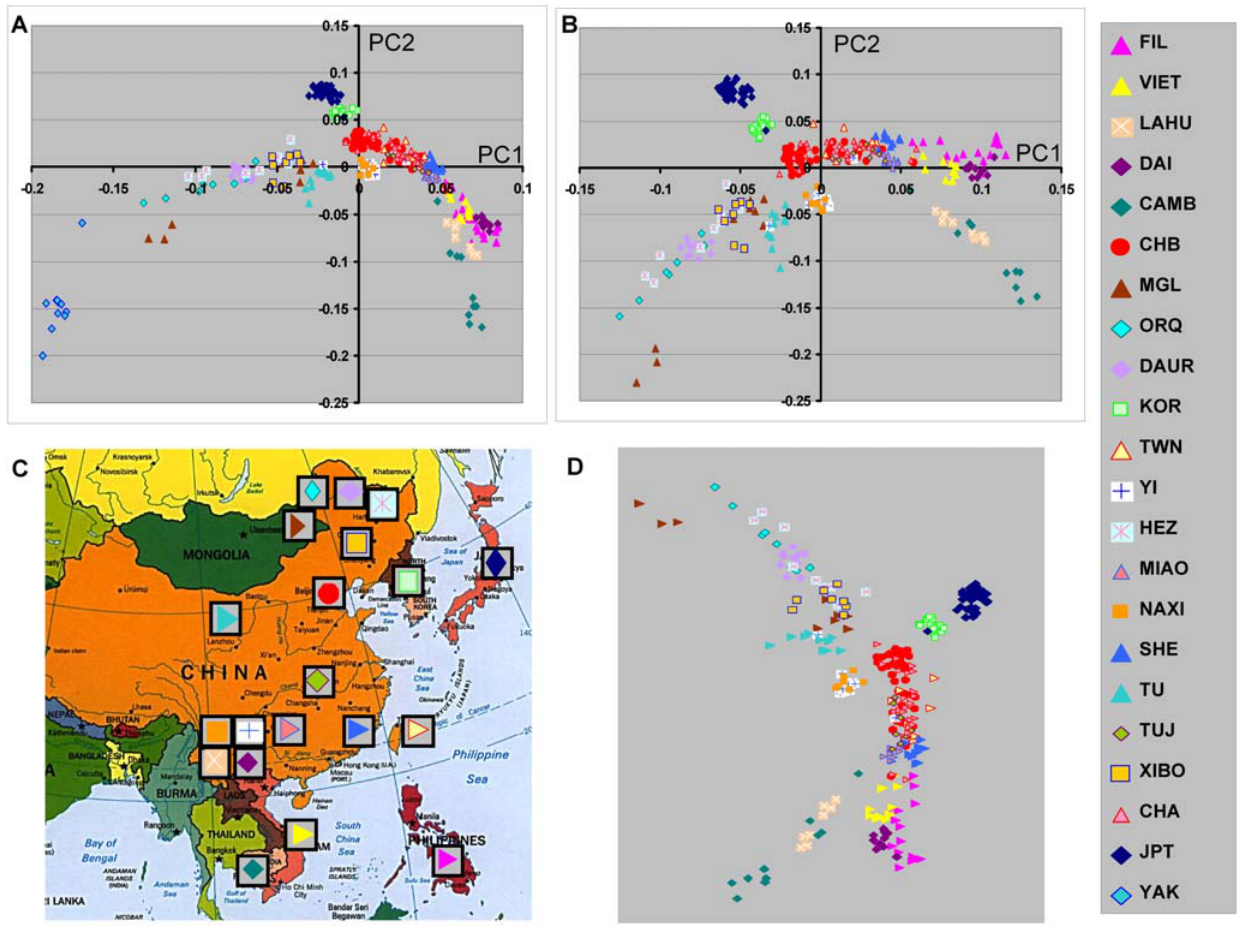
Figure 1. Principal component analyses of substructure in a diverse set of subjects of East Asian descent. Graphic representation of the first two PCs based on analysis with . 200 K SNPs are shown. Color code shows subgroup of subjects for each population group. The subjects included Filipino (FIL), Vietnamese (VIET), Lahu, Dai, Cambodian (CAMB), Han Chinese (CHB), Mongola (MGL), Oroqen (ORQ), Daur, Korean (KOR), Chinese Americans from Taiwan (TWN),Yi, Hezhen (HEZ), Miaozu (MIAO), Naxi, She, Tu, Tujia (TUJ), Xibo, Chinese Americans (CHA), Japanese (JPT), and Yakut (YAK). A , Analyses including the Yakut population group. B , Analysis without Yakut is shown. C , Approximate geographic origin of population group is depicted on a map of East Asia (downloaded from University of Texas Library website). The positions of the HGDP population groups are based on the collection site information[12] and the other population groups were placed based on self-identified country or region of origin. [Note: Yakut are not shown on the map since this population is from Siberia and is a considerable distance north of the depicted region.] D , Shows rotated results of PC1 and PC2 to assist illustration of geographic correspondence of ethnic group locations.